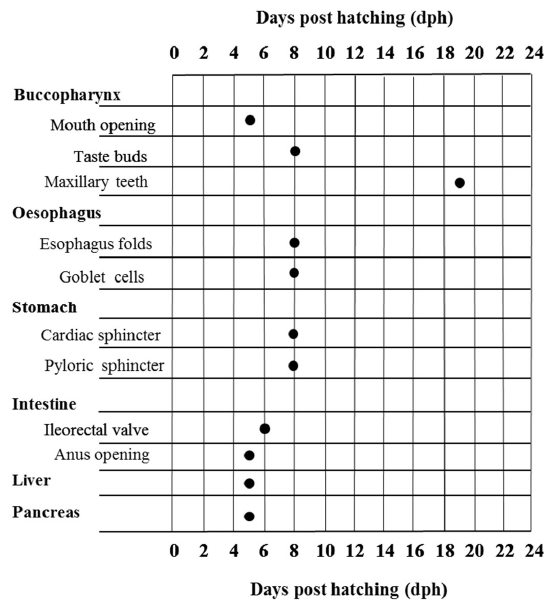
Figure 6. Schematic representation of the main structures of the digestive system identified. The time of appearance of each structure is presented with a black solid circle as a function of days post hatching (dph, horizontal